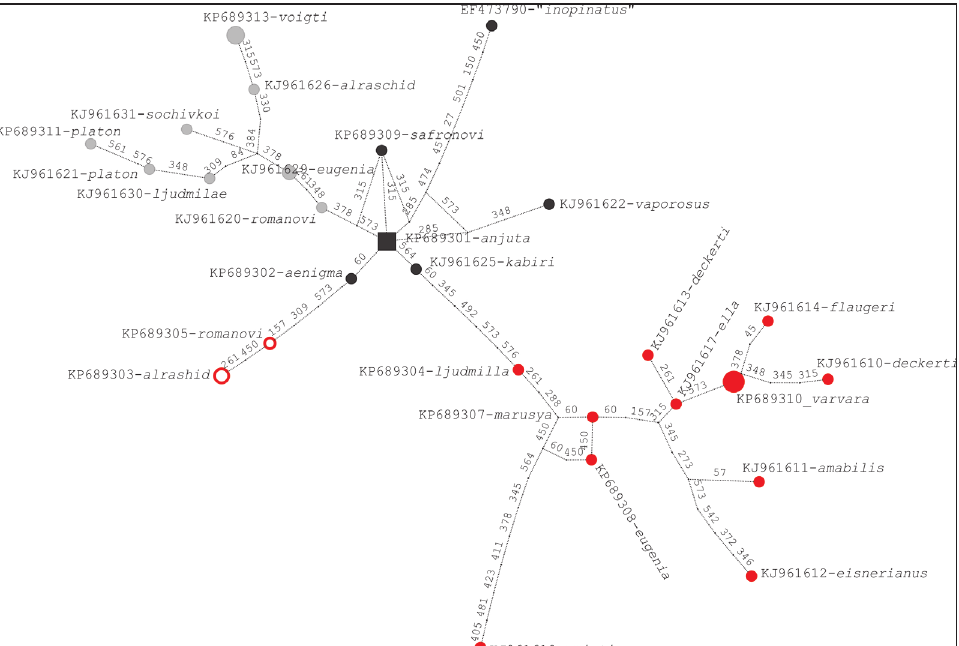
Figure 8. The haplotypes network of Koramius charltonius in Central Asia, median-joining, constructed us- ing only verified sequences. Haplotype group A – red dots; group B – red circles; group C – black dots; group D – grey dots. See text for